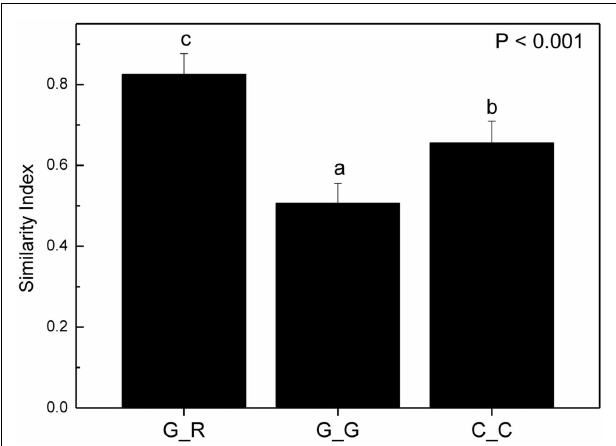
FIGURE 7 | Morisita–Horn similarity indices for combinations of ectomycorrhizal species assemblages on the roots of a distinct beech genotype with those on roots of other beech genotypes in the same soil core (G_R, n = 29), with the same beech genotype in different soil cores (G_G, n = 31) and of the EcM assemblages in all soil cores used for this analysis (C_C, n = 26). Bars indicate means ± SE. Different letters indicate significant differences at p <